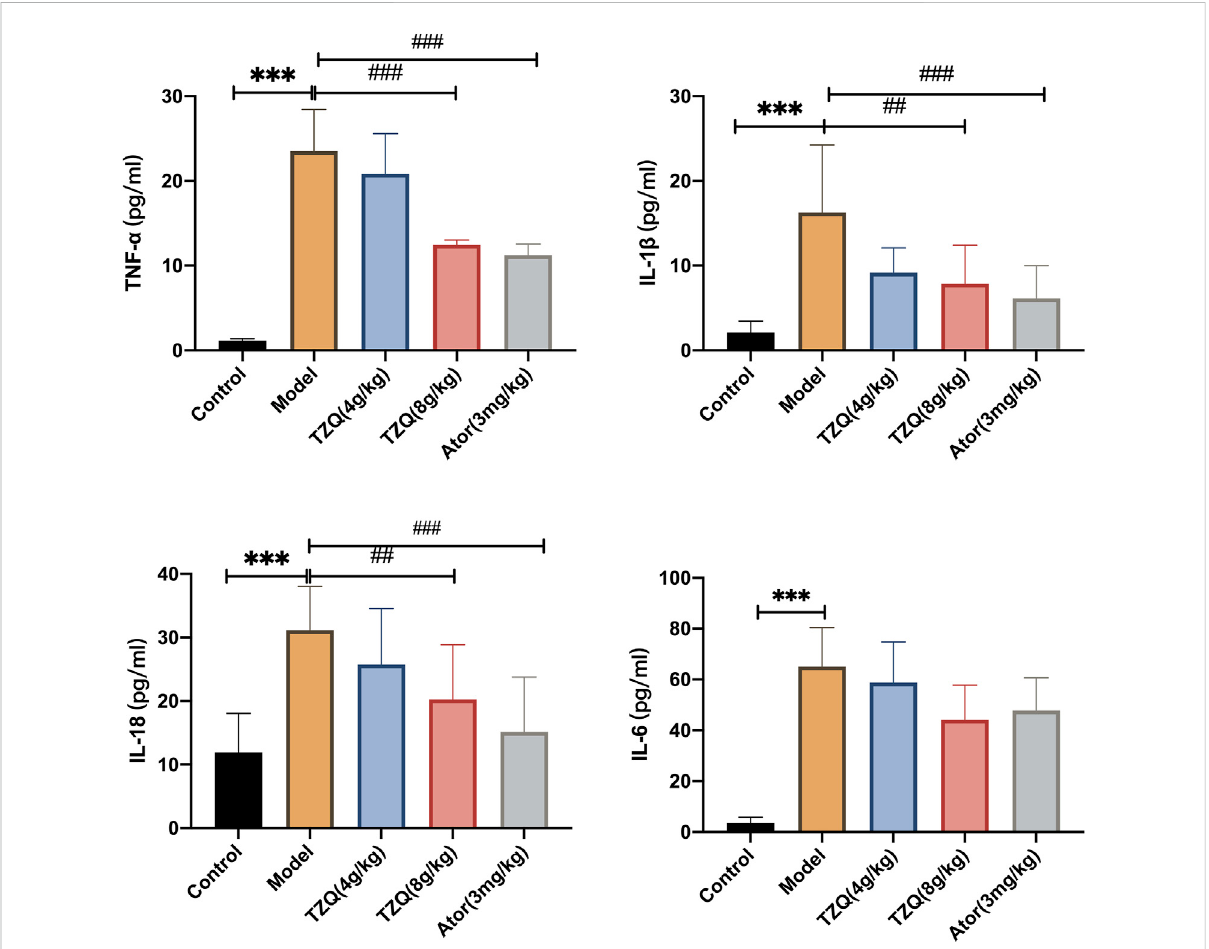
FIGURE 4 Effect of TZQ on in fl ammation. n = 4 mice for each group, ** p < 0.05, *** p < 0.01 versus Control, ## p < 0.05, ### p < 0.01 versus Model.